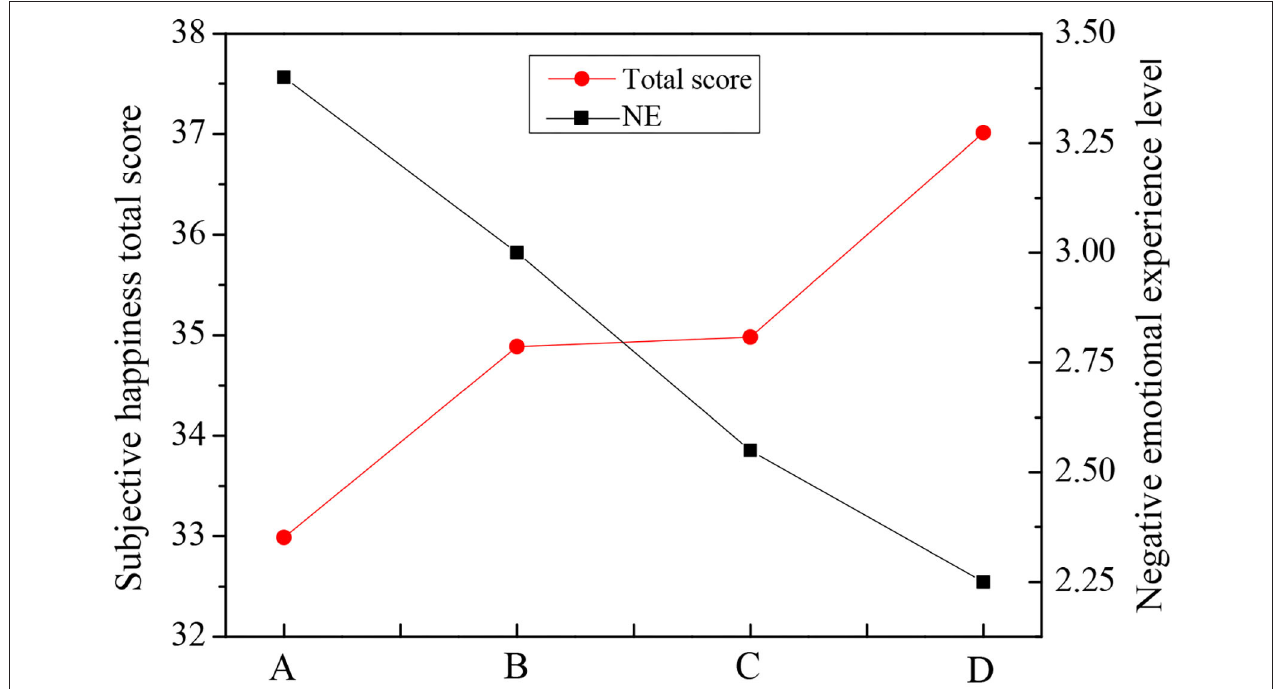
FIGURE 5 | The mean value of total happiness score and NE positive emotion score of the four groups plotted.